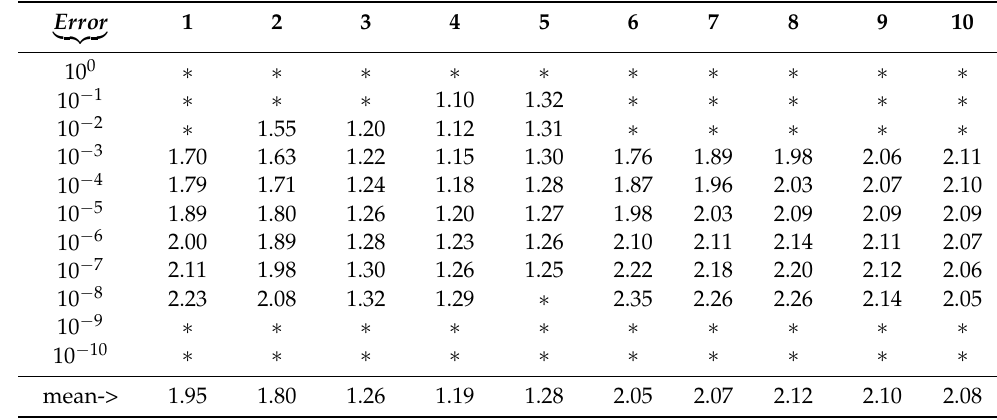
Table 8. Efficiency ratios of DP5(4) vs. NEW(4) for problems 1–10 in the interval [ 0,20 π ] and global errors achieved over the whole integration interval. Stars indicate unavailability of data to attain the perspective errors.